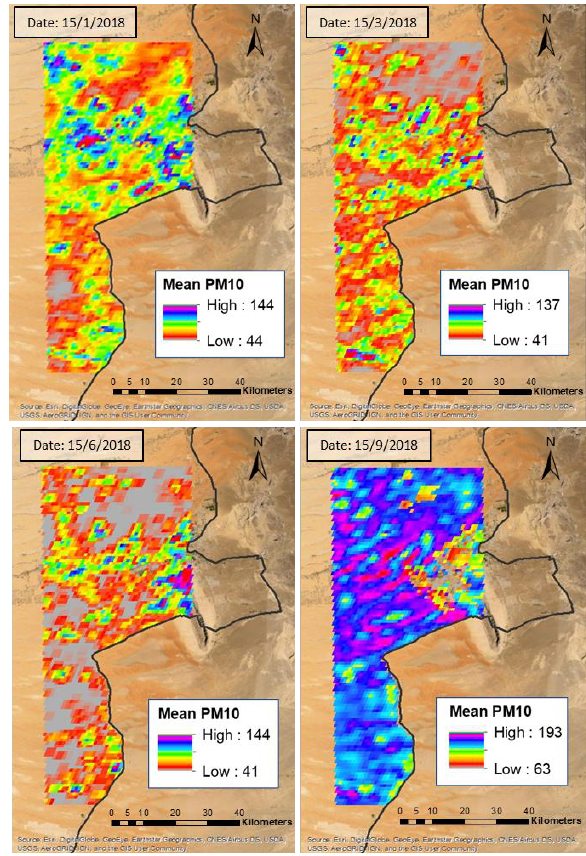
Figure 8 . Daily mean PM10 concentration maps of Al Ain city for four different dates in